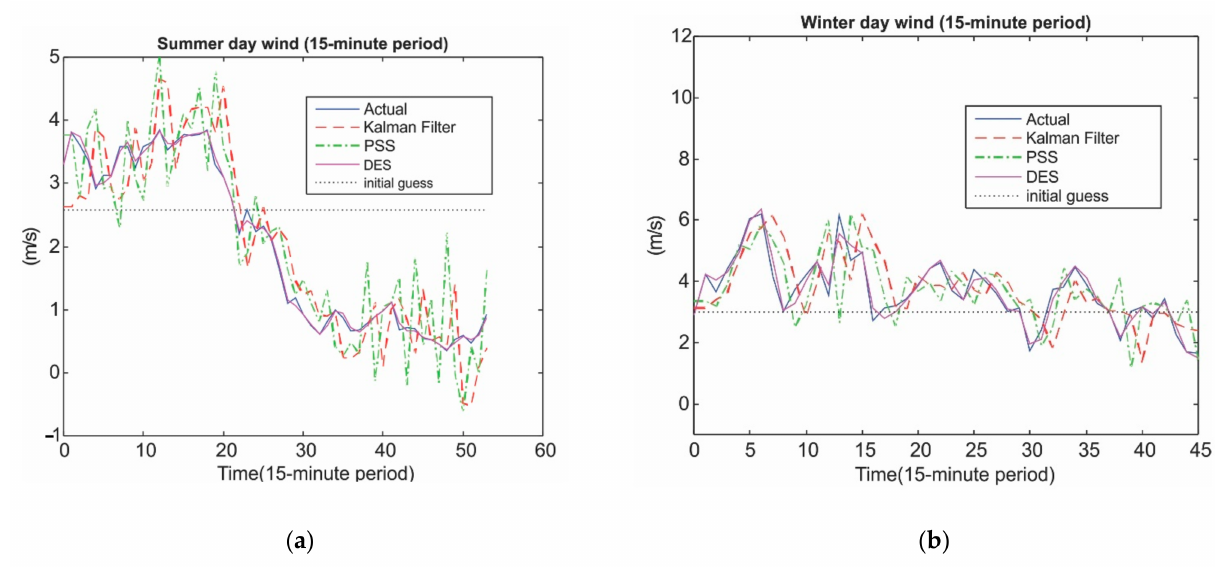
Figure 3. Wind speed prediction. ( a ) Summer day wind, ( b ) Winter day wind.